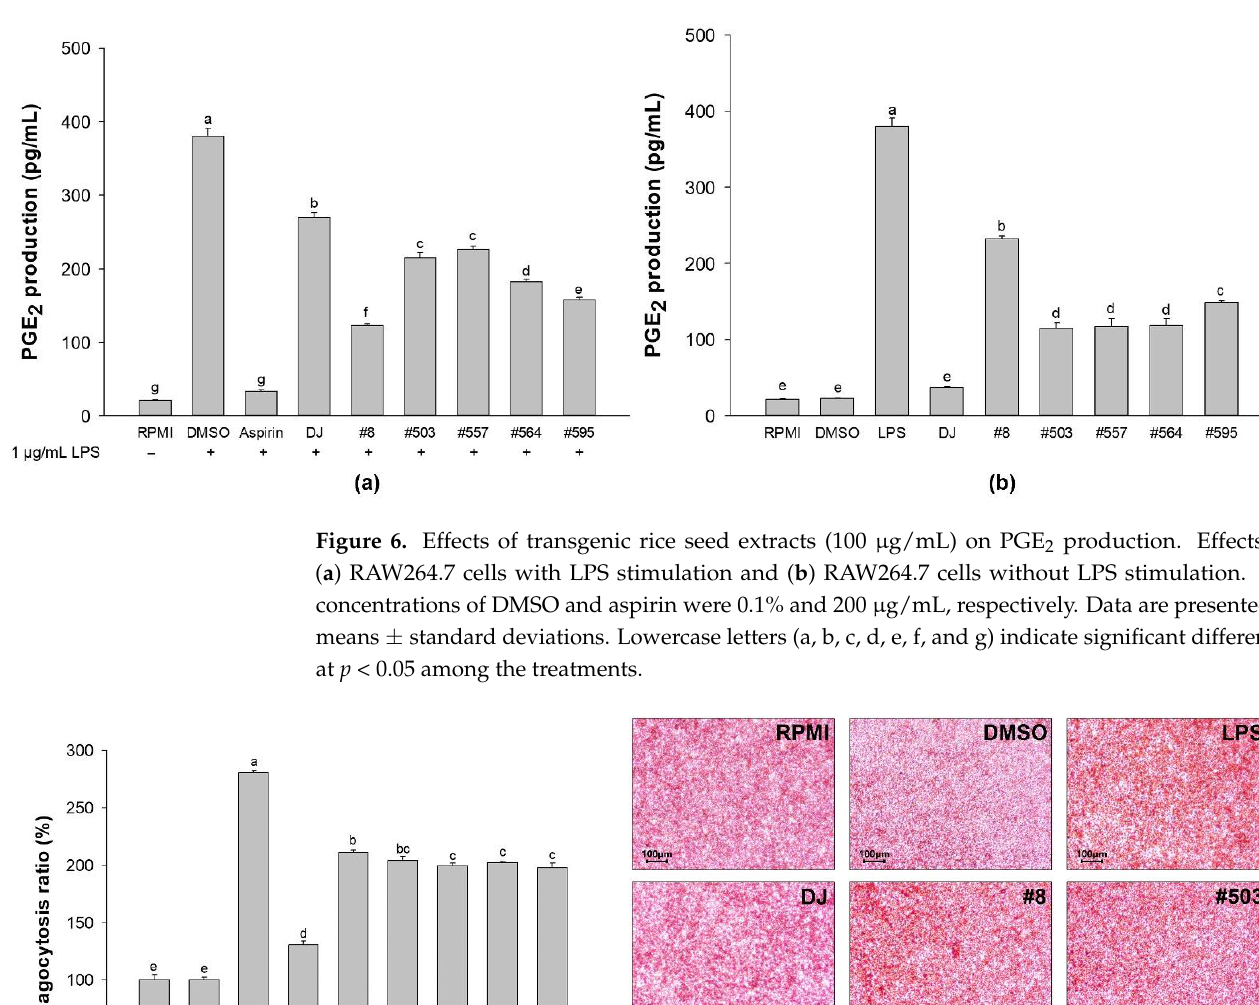
Figure 6. Effects of transgenic rice seed extracts (100 µg/mL) on PGE 2 production. Effects on ( a ) RAW264.7 cells with LPS stimulation and ( b ) RAW264.7 cells without LPS stimulation. The concen- trations of DMSO and aspirin were 0.1% and 200 µg/mL, respectively. Data are presented as means ± standard deviations. Lowercase letters (a, b, c, d, e, f, and g) indicate significant differences at p < 0.05 among the treatments.